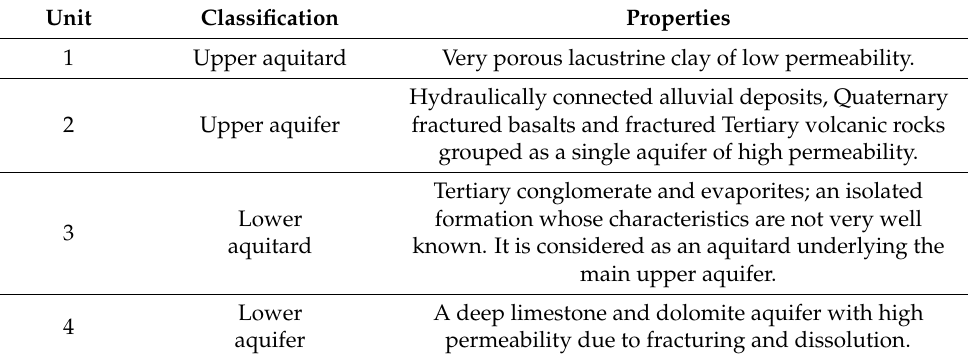
Table 1. Hydrogeological units.